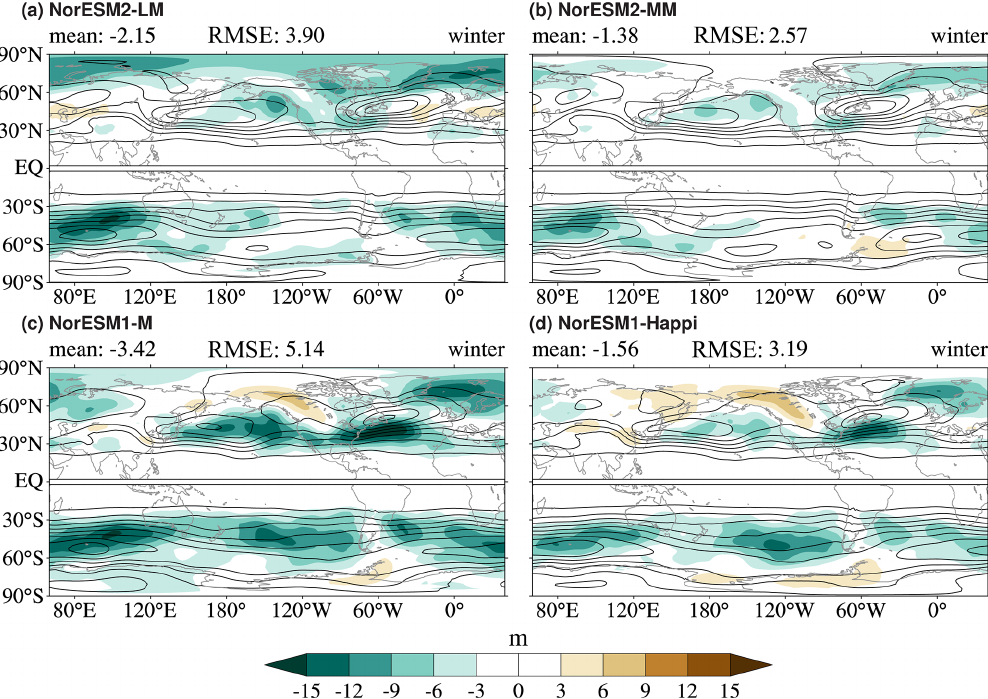
Figure 17. Ensemble-mean model bias for the extratropical storm tracks in terms of bandpass-filtered variability (colours) shown with the present-day model climatology (solid black contours; values from 8m with intervals of 8m) for NorESM2-LM (a) , NorESM2-MM (b) , NorESM1-M (c) , and NorESM1-Happi (d) . Panels show the winter season for both hemispheres (DJF for the NH and JJA for the SH). The storm tracks are plotted in terms of the standard deviation of the bandpass-filtered geopotential height field at 500hPa (Z500). The model data are taken from the CMIP6 historical members for NorESM2-LM (three members) and NorESM2-MM (three members) for the years 1980–2009 and from the CMIP5 historical members for NorESM1-M (three members) and NorESM1-Happi (three members) for the years 1976–2005. The bias is taken with respect to ERA-Interim (years 1980–2009 for NorESM2-LM/MM and 1979–2008 for NorESM1- M/Happi). Units are